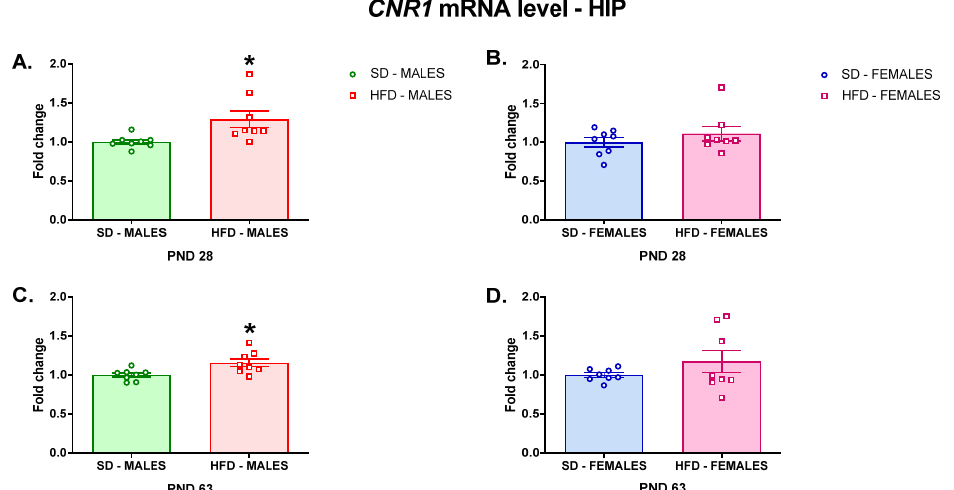
Figure 3. Changes in the Cnr1 mRNA level in the HIP of adolescent ( A ) male and ( B ) female offspring or young adult ( C ) male and ( D ) female offspring whose mothers were fed on an SD or HFD during pregnancy and lactation. HFD—high-fat diet; HIP—hippocampus; PND—postnatal day; SD—standard diet. Data are presented as the mean ± SEM with individual value plots. N = 8 rats/group. * p < 0.05 vs. SD.